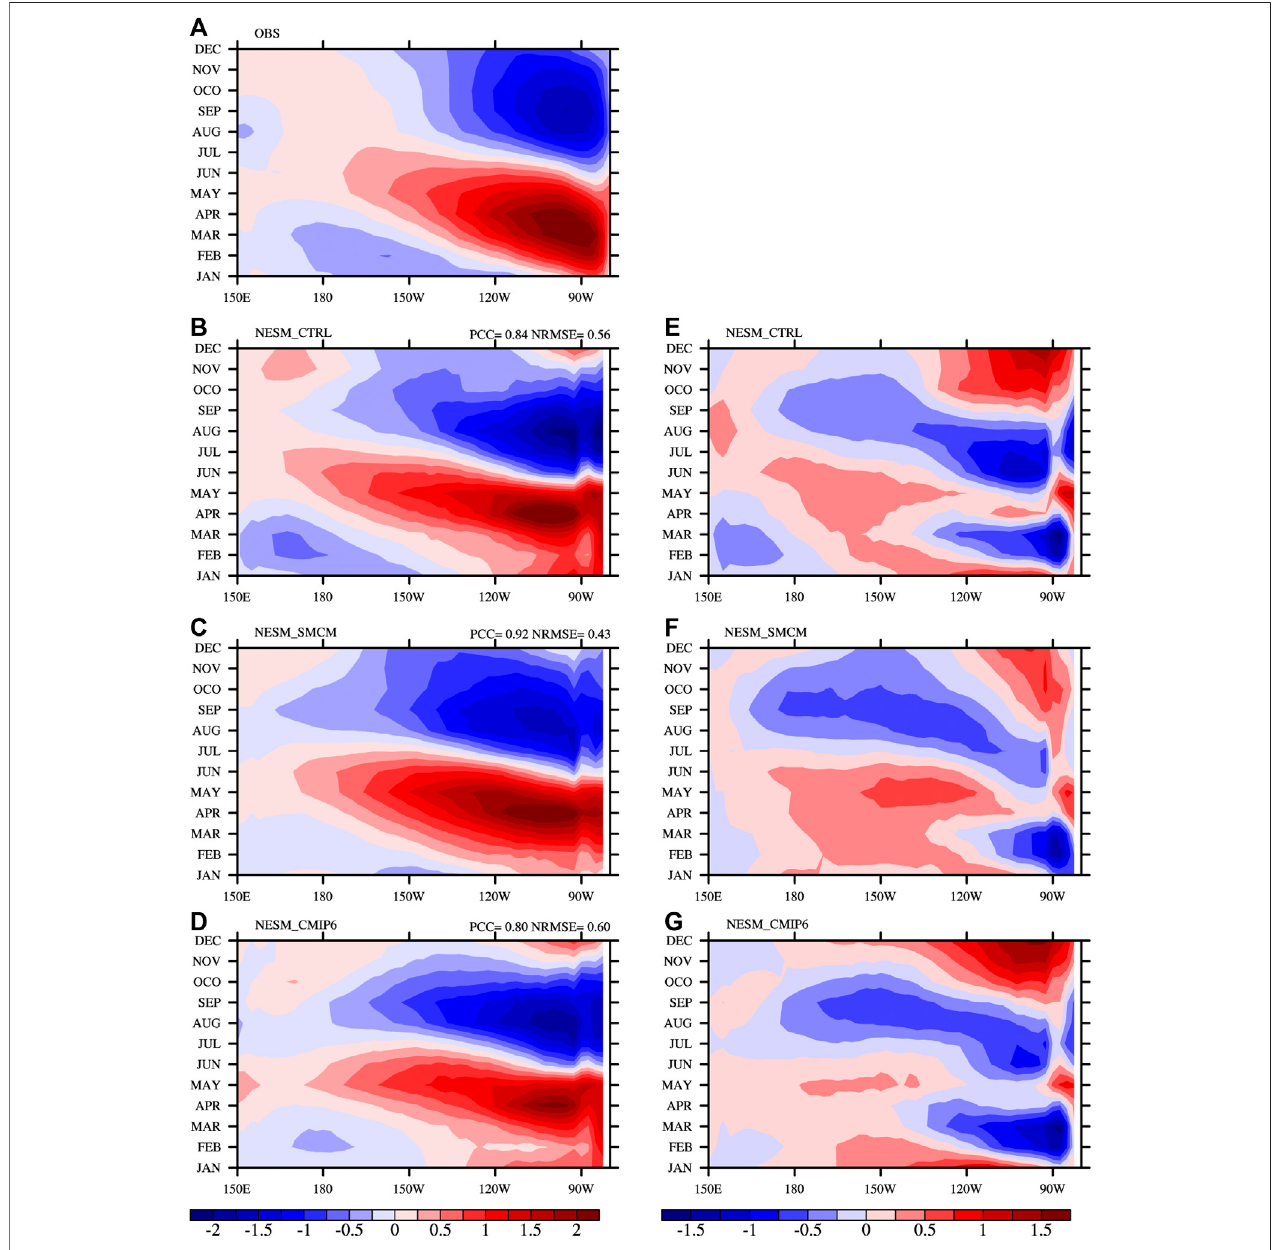
FIGURE 4 | Seasonal cycle of the SST anomaly (left panel; ° C) along the equator (averaged over 5 ° S – 5 ° N): (A) observations, (B) NESM_CTRL, (C) NESM_SMCM, and (D) NESM_CMIP6, and the differences of (E) NESM_CTRL, (F) NESM_SMCM, and (G) NESM_CMIP6 relative to the observations.